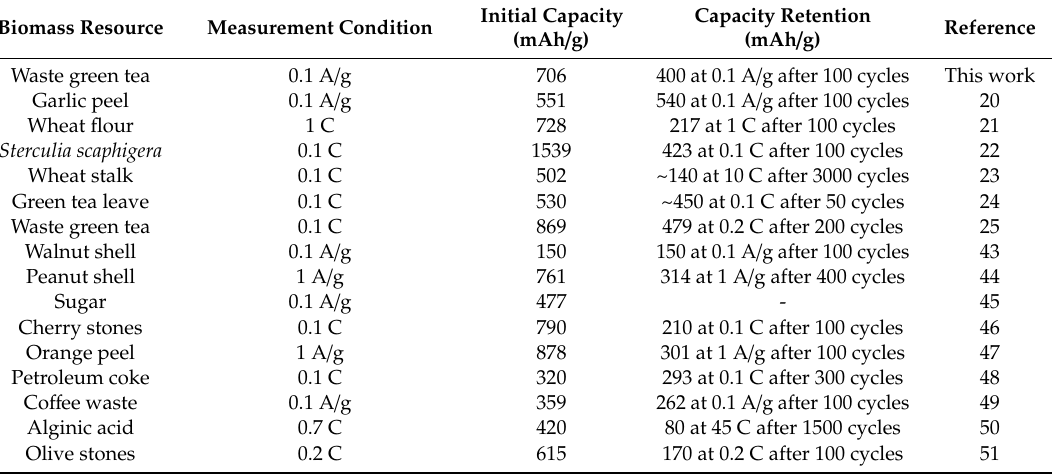
Table 1. Comparison of electrochemical performances for various biomass-derived carbon nanostructures used as lithium ion battery (LIB) anode